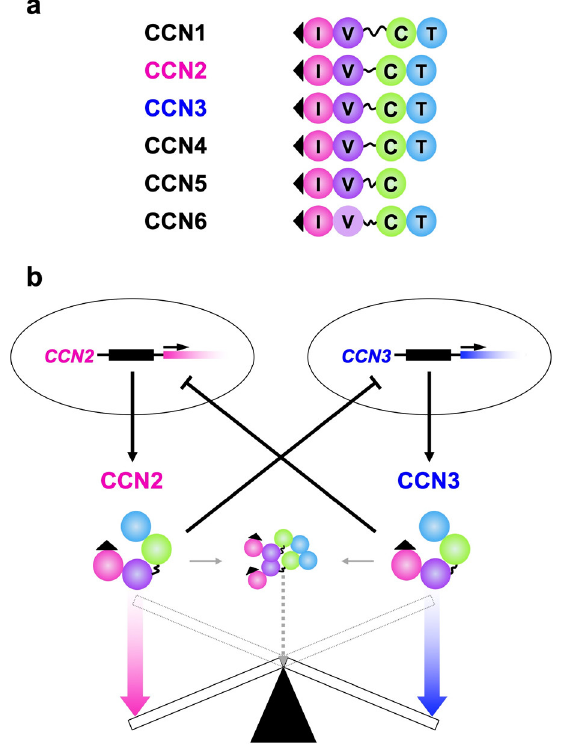
Figure 1. ( a ) Structures of all of the CCN family members. I, V, T and C indicate insulin-like growth factor binding protein-like (IGFBP), von Willebrand factor type C repeat (VWC), thrombospondin I type I repeat (TSP1) and C-terminal cystine-knot (CT) modules, respectively. A series of 38 cysteine residues in these modules are strictly conserved, whereas CCN6 lacks four of them in VWC. Signal peptides for secretion on the IGFBP modules (solid triangles) and hinges between VWC and TSP are also illustrated. The hinge domain is highly variable among the members, which is particularly long in CCN1. ( b ) The yin–yang collaboration of CCN2 and CCN3. The gene products with apparently opposite functions negatively regulate the expression of the other, while conferring opposing biological effects.